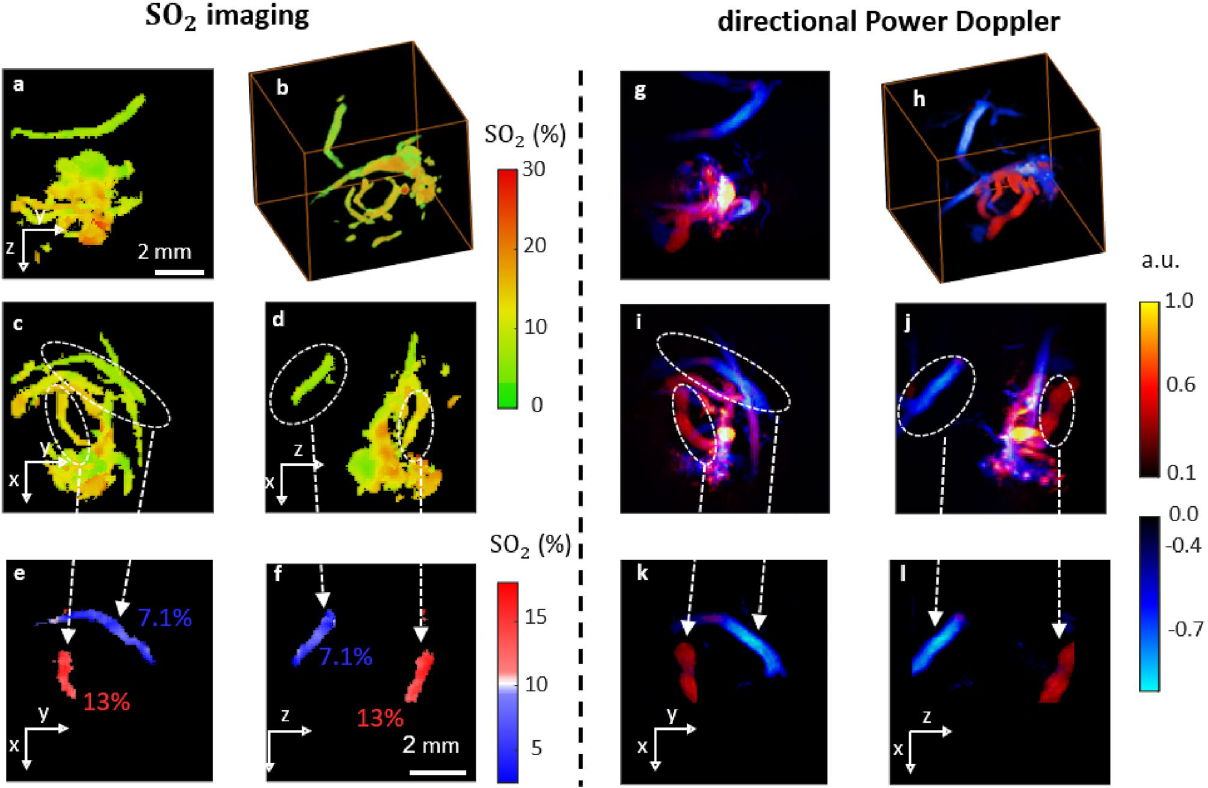
Figure 6. Simultaneous and complementary SO 2 imaging and Directional Power Doppler imaging in chicken embryo. 2D images are maximum intensity projections through the 3D data. Left panel ( a–f ) SO 2 imaging. ( e,f ) correspond to Maximum Intensity Projection images through ellipsoidal regions of interest shown in ( c,d ). The range and type of colormap for ( e,f ) has been optimized to highlight the difference in SO 2 values for two vessels with opposite flow directions. Right panel ( g–l ): Directional Power Doppler imaging. ( k,l ) correspond to Maximum Intensity Projection images through ellipsoidal regions of interest shown in ( i,j ), highlighting the difference in flow directions for each pair of